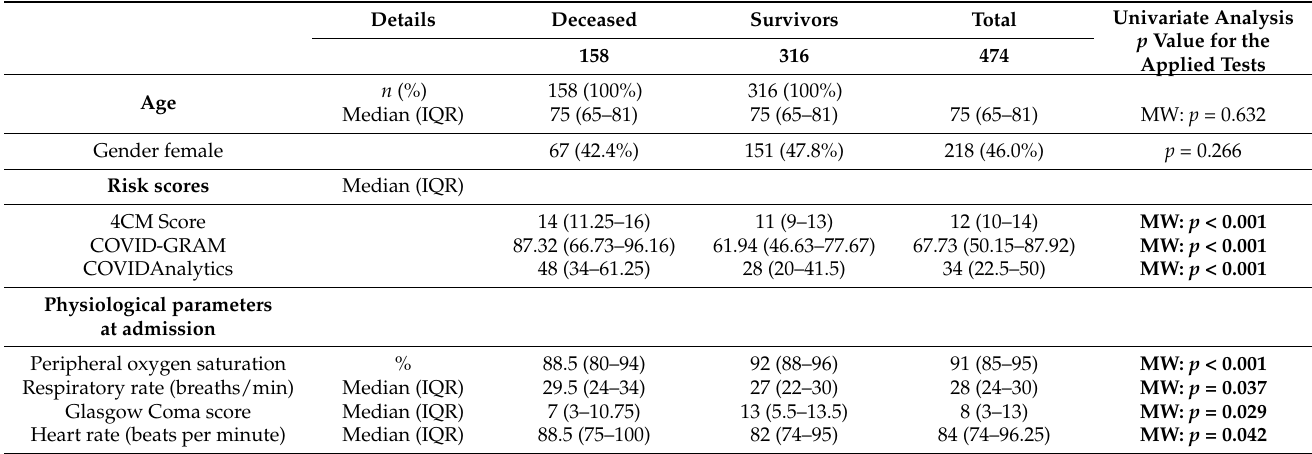
Table 1. Summary statistics, by deceased vs. control